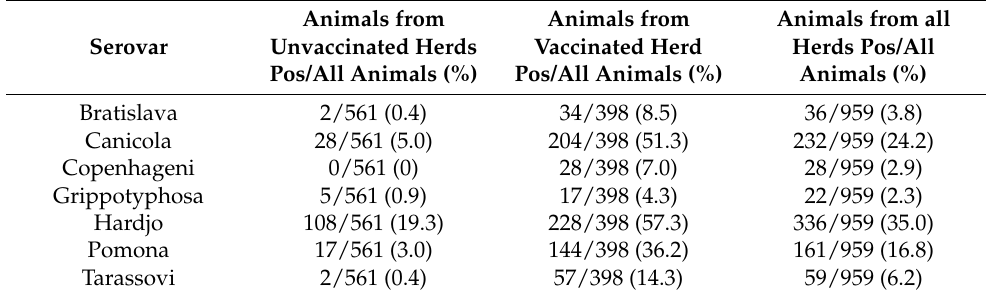
Figure 2. Heat map of microscopic agglutination test (MAT) seropositivity to the different serovars of Leptospira in unvaccinated herds. Table 2. Overall seroprevalence to 7 Leptospira serovar in cattle from 20 unvaccinated dairy herds and one vaccinated dairy herd in Boyac á department (Columbia) that were tested using microscopic agglutination